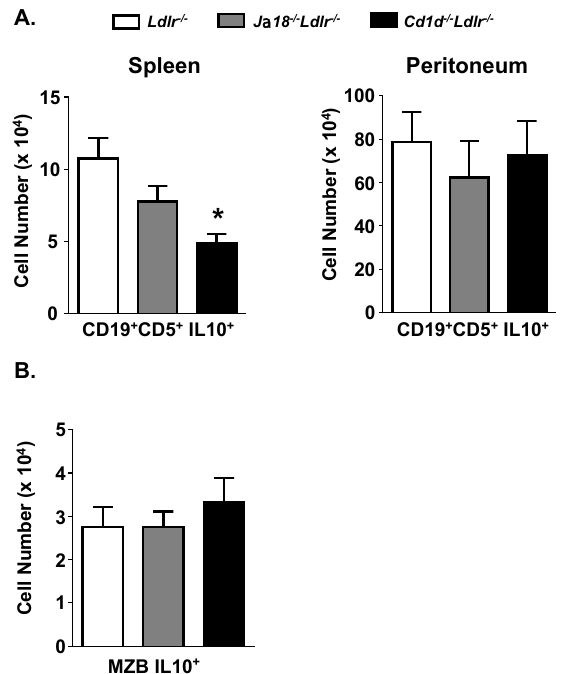
Figure 4. ( A ) Reduced CD19 + CD5 + IL10 + B lymphocytes in the spleen of Cd1d − / − Ldlr − / − mice. Splenocytes and peritoneal cells from chow fed female mice were analyzed for CD19 + CD5 + IL-10 + B cells via flow cytometry. ( B ) Splenocytes were also analyzed for IL10 + MZB cells (CD19 + CD23 lo CD21 hi ) by flow cytometry. The results are the mean ± SEM of n = 7–9 pooled from two independent experiments. Significance: * p = 0.001 vs. Ldlr − / − mice.